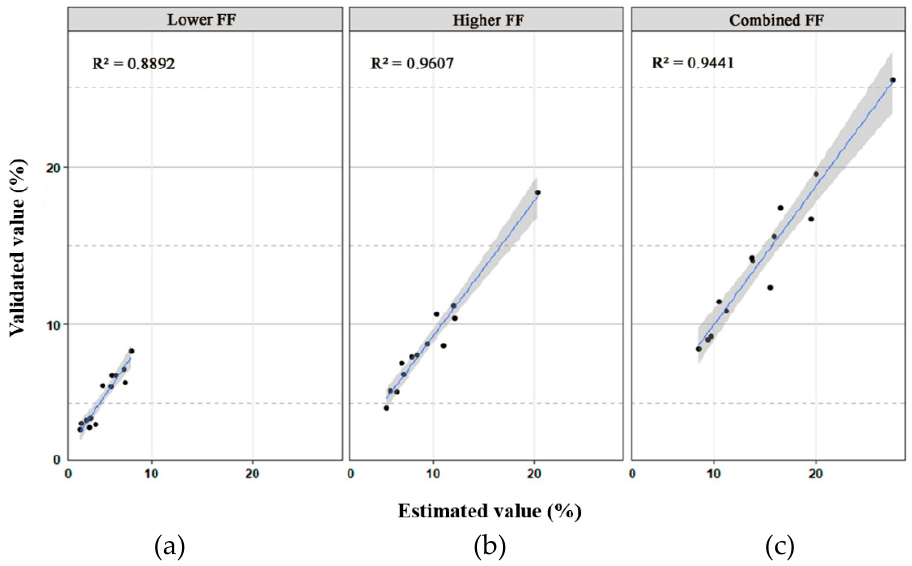
Figure 3. Scatter plots with 95% confidence intervals of the validated value and estimated value of the lower fetal fraction (FF) ( a ), higher FF ( b ), and combined FF ( c ) for 13 dizygotic (DZ) twin cases. The coefficient of determination (R-square) is also shown in the upper left corner of each plot.